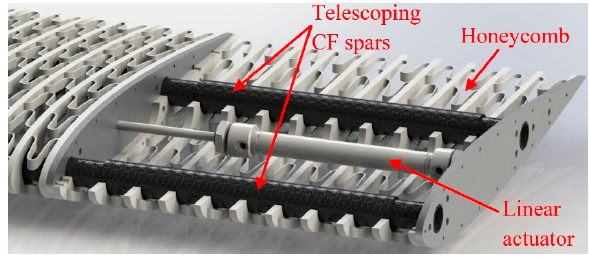
Figure 3. Cutaway view of a single partition.